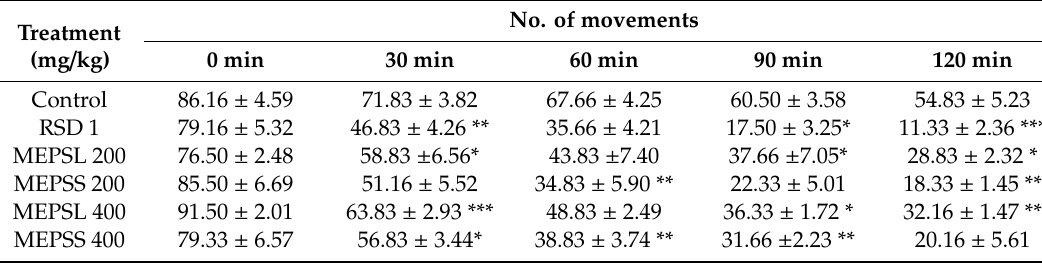
Table 3. Anxiolytic e ff ects of MEPSL, MEPSS, and diazepam on a number of movements in open field test in mice.